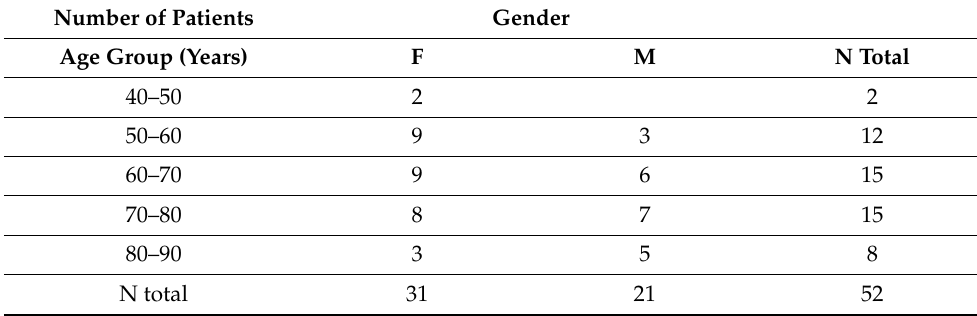
Table 3. Patients categorized by gender according to their age group.